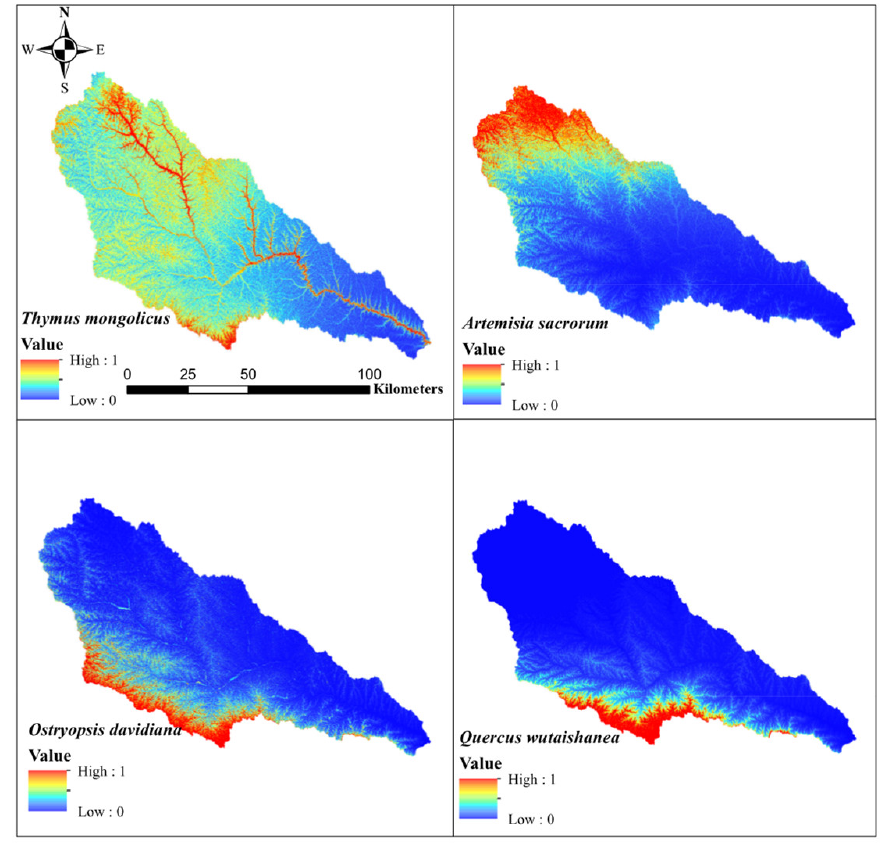
Figure 2. Potential geographical distribution of four typical plants on the Yanhe River catchment as predicted by MaxEnt. Table 3. Environmental variables and their contributions to the distribution of four native species (the environmental variables that contribute less than 5% to the distribution of the four local spe- cies are not shown here).